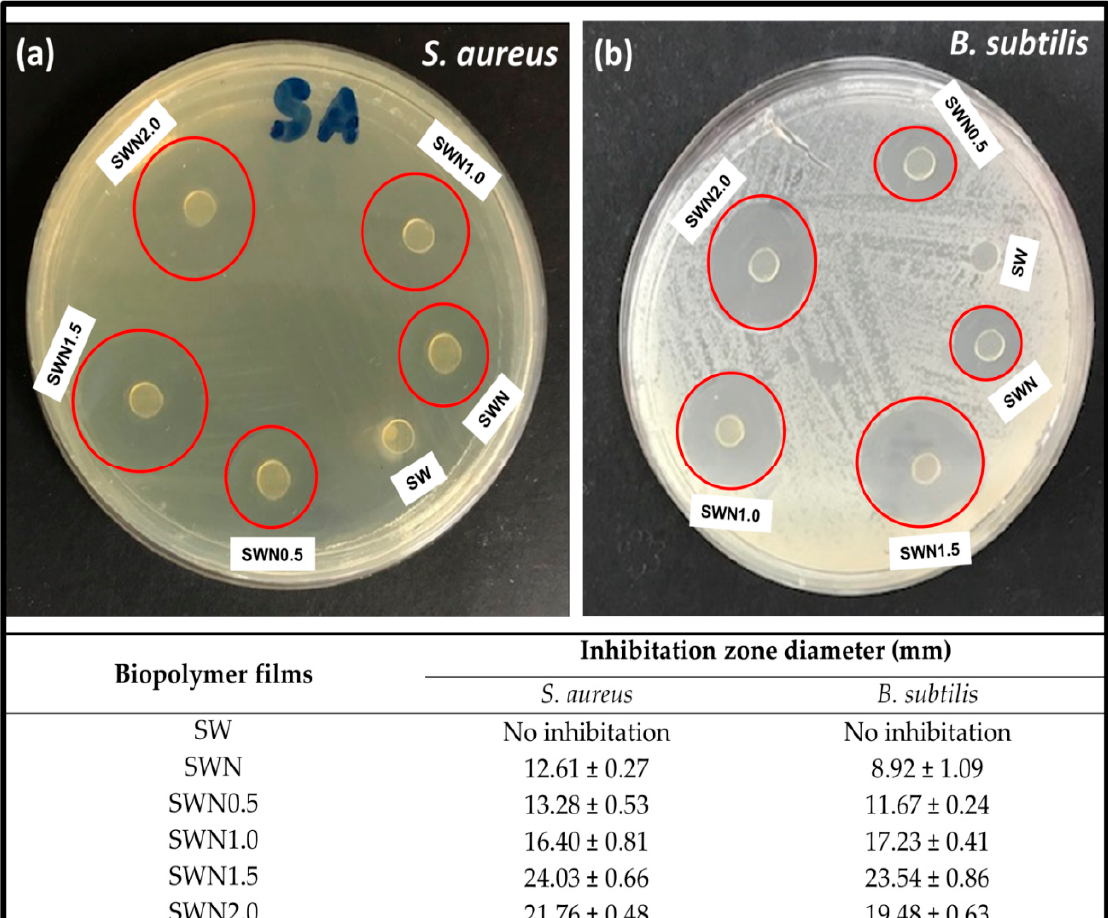
Figure 8. Photographic images of inhibition zone measurement results of seaweed film (SW), seaweed–neem composite film (SWN) and irradiated seaweed–neem film (SWN) at different dosage (kGy) against; ( a ) Staphylococcus aureus ; ( b ) Bacillus subtilis .